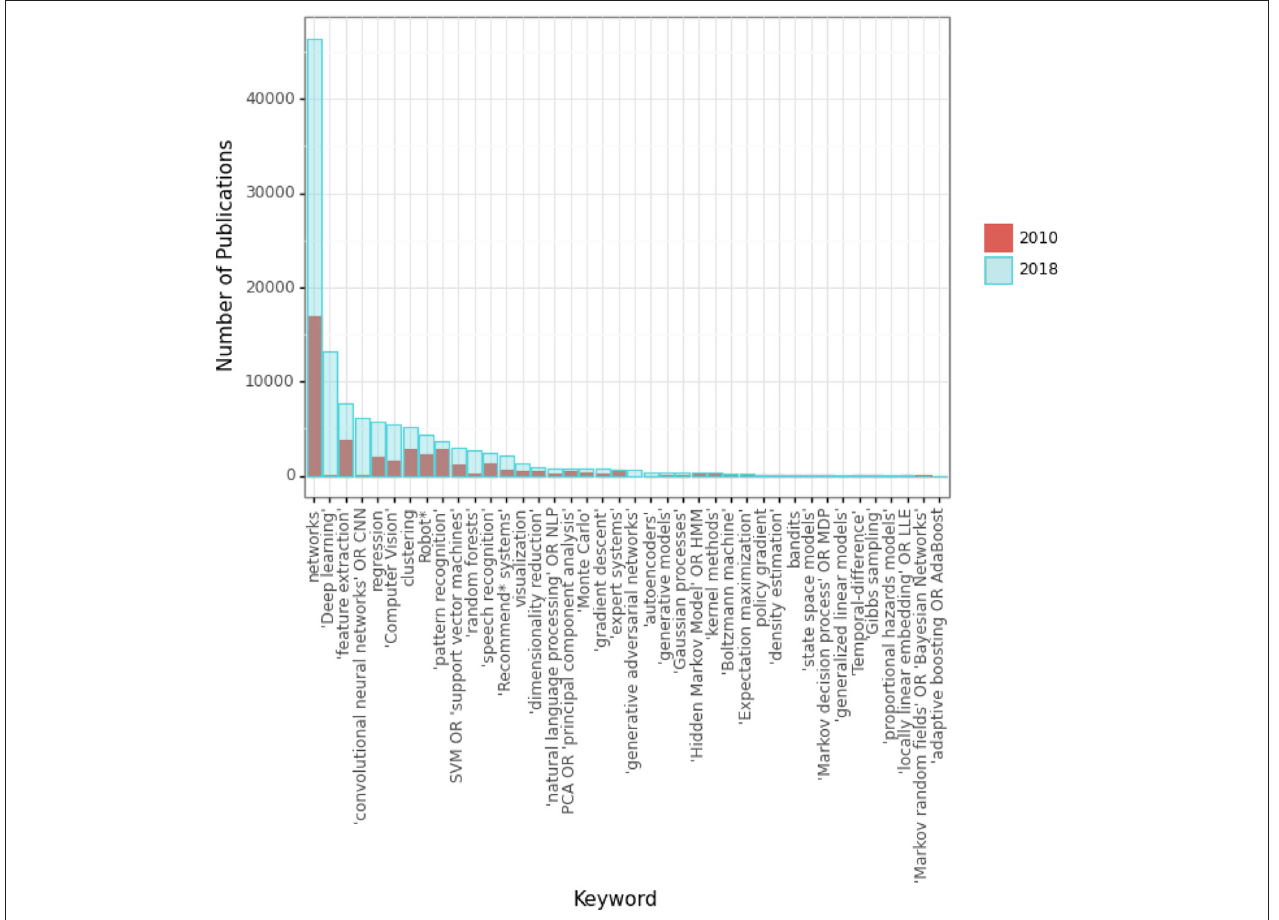
FIGURE 3 | Number of publications with each technical domain keyword in 2010 and